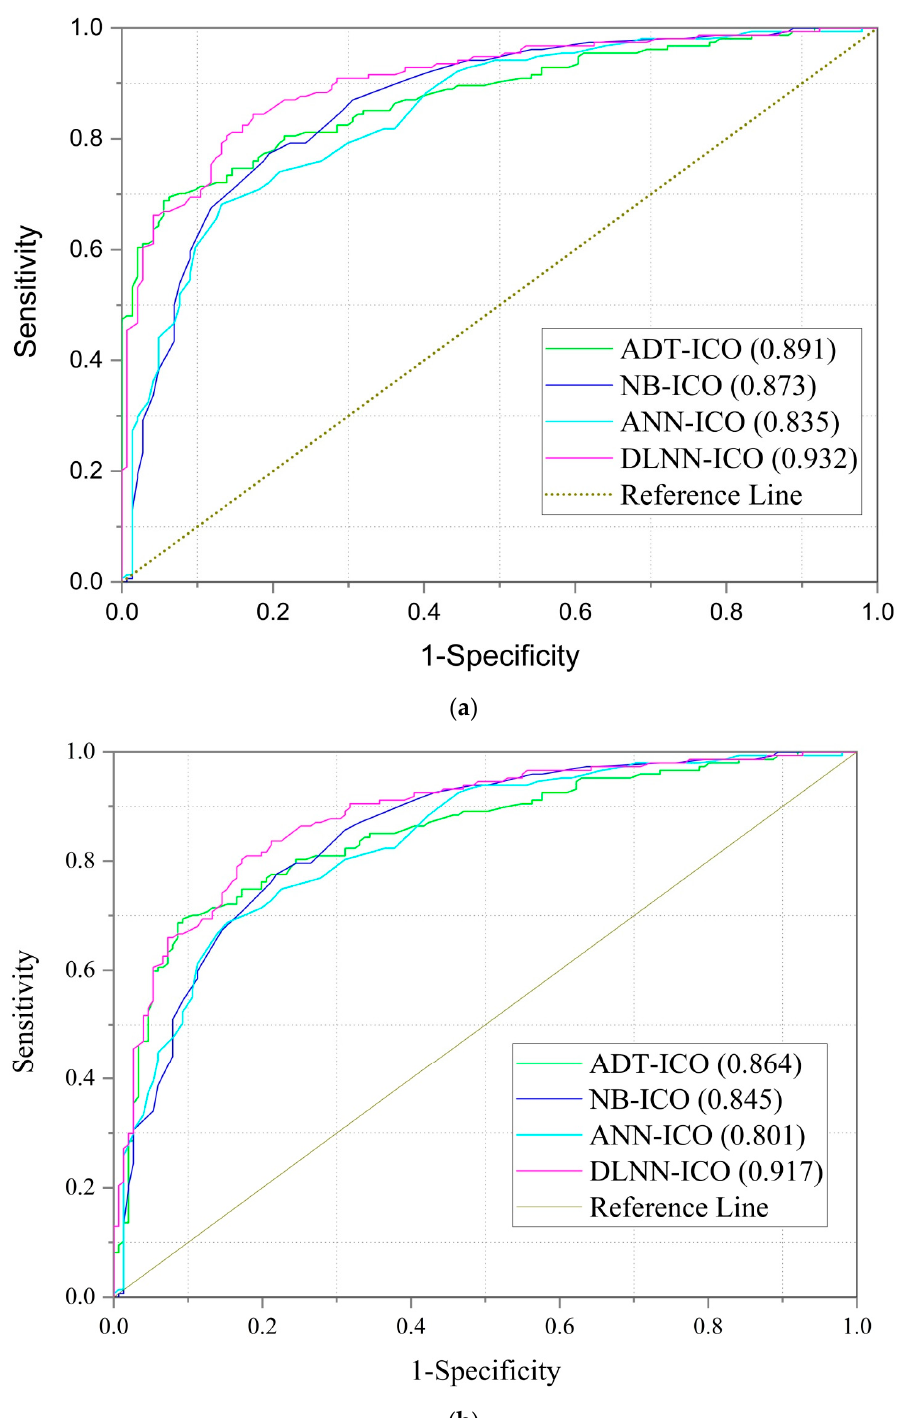
(AUC = 0.917) in the validation datasets.